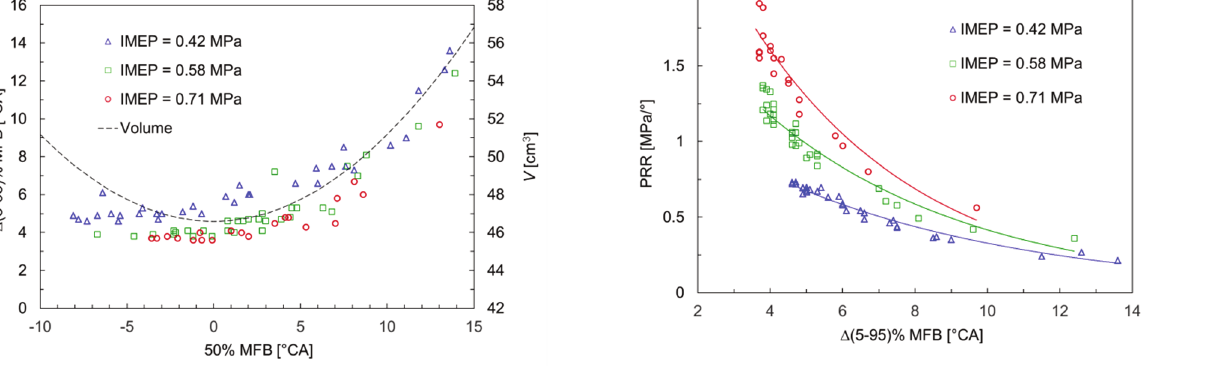
Fig. 5. Pressure rise rates as a function of combustion duration for all investigated